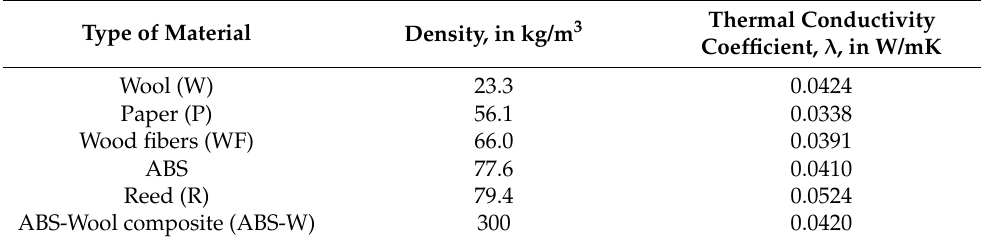
Table 1. Density and thermal conductivity coefficient of the insulation materials.